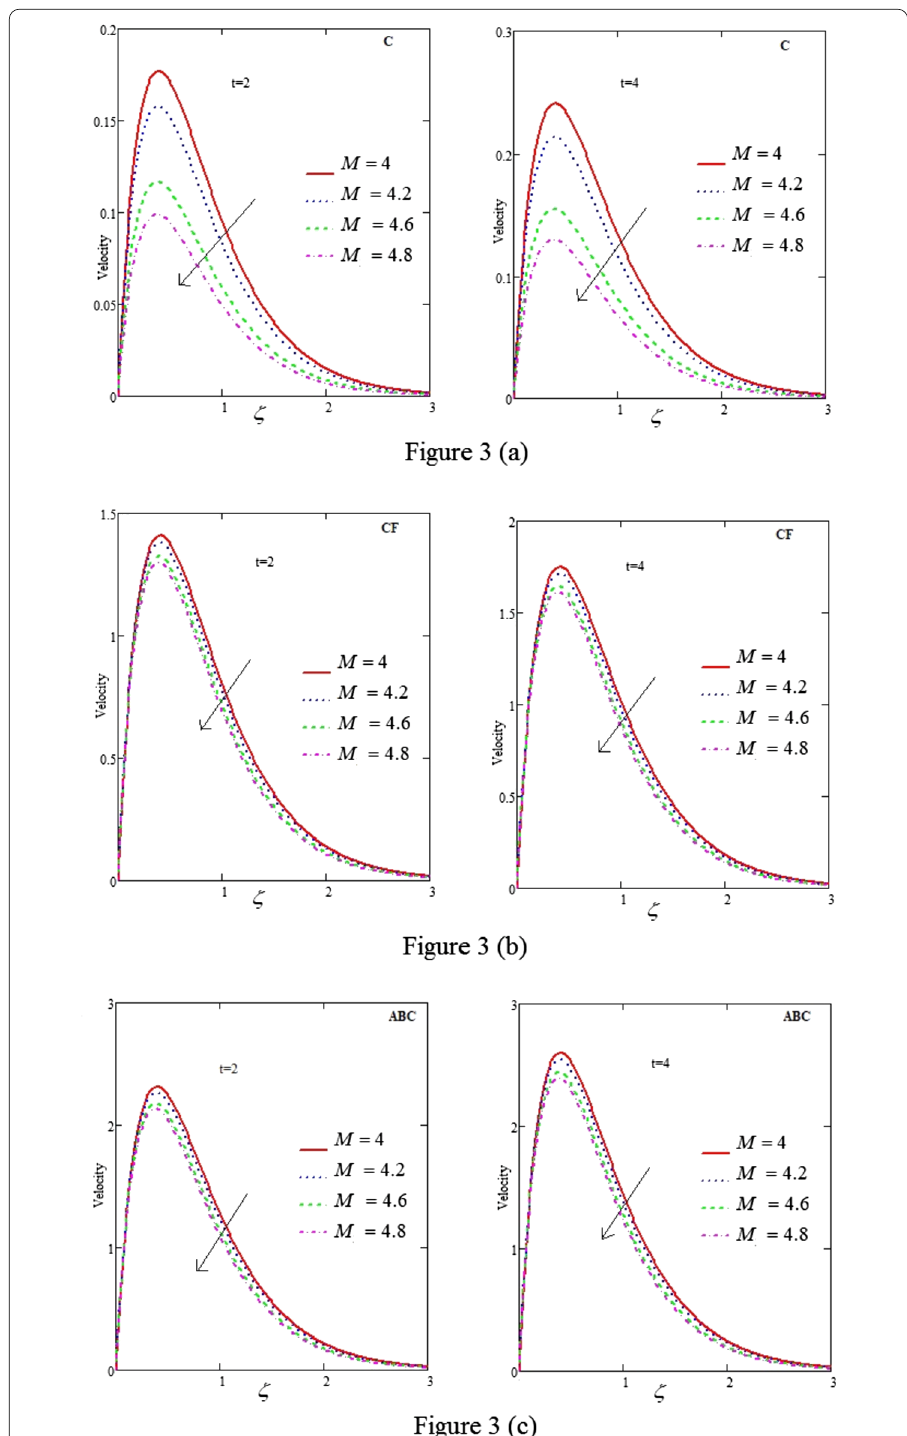
Figure 3 ( a , b , c ). Velocity curves belonging to C, CF and ABC for various values of M , where γ = 0.1, Pr = 6, Sc = 8, Gr = 6, Gm = 8 and λ =